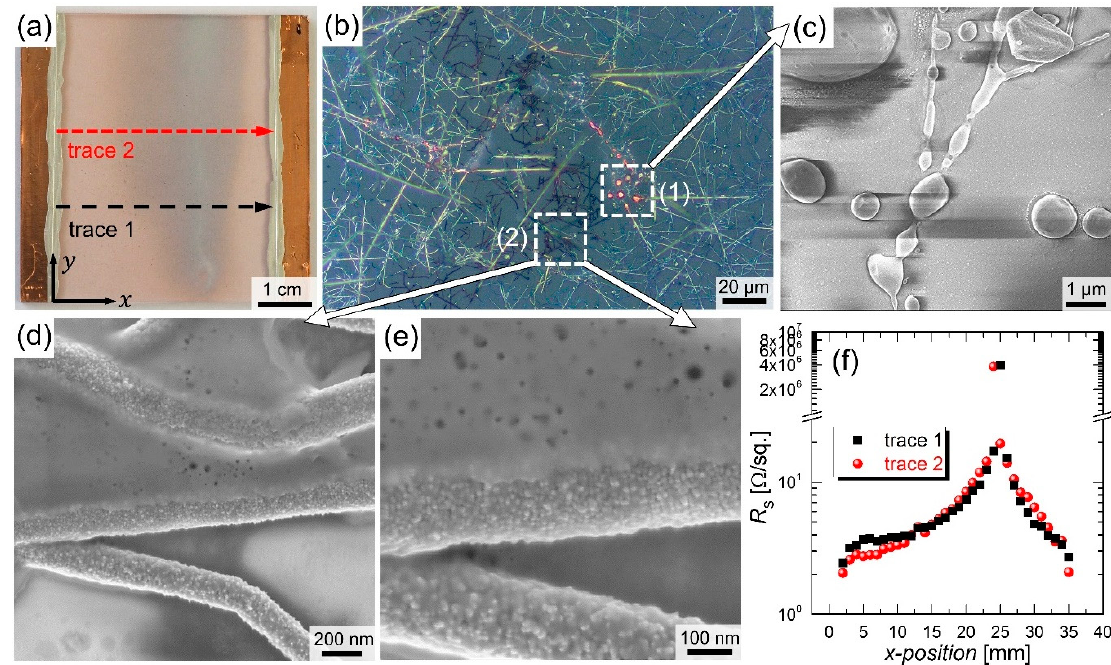
Figure 8. ( a ) Photo for a CuNW heater with a sheet resistance of around 3.2 Ω /sq. after electrical breakdown. The heater was subjected to an electrical input power of 6 W for around 17 h; ( b ) Microscope images for the CuNW film after an electrical breakdown at a position with >M Ω sheet resistance; ( c – e ) SEM-images for the CuNW heater shown in (a,b) at a position with >M Ω sheet resistance; ( f ) R S across the CuNW heater as a function of the measurement position, as indicated in ( a ).